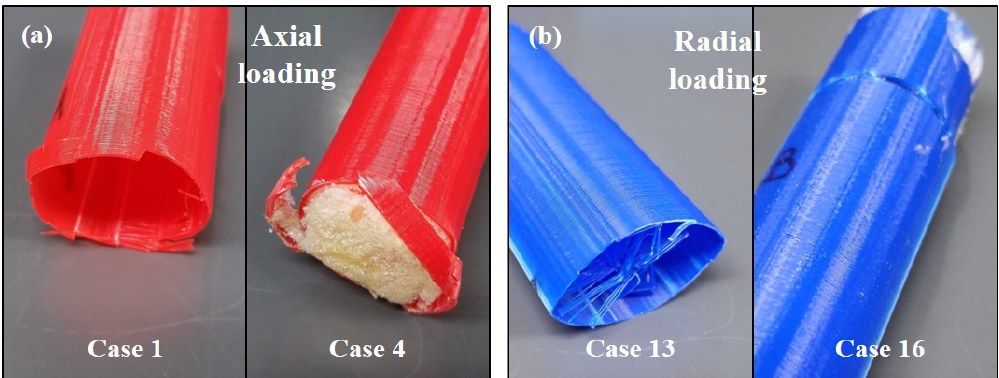
Figure 6. Examples of post-buckling specimens under: ( a ) axial and ( b ) radial